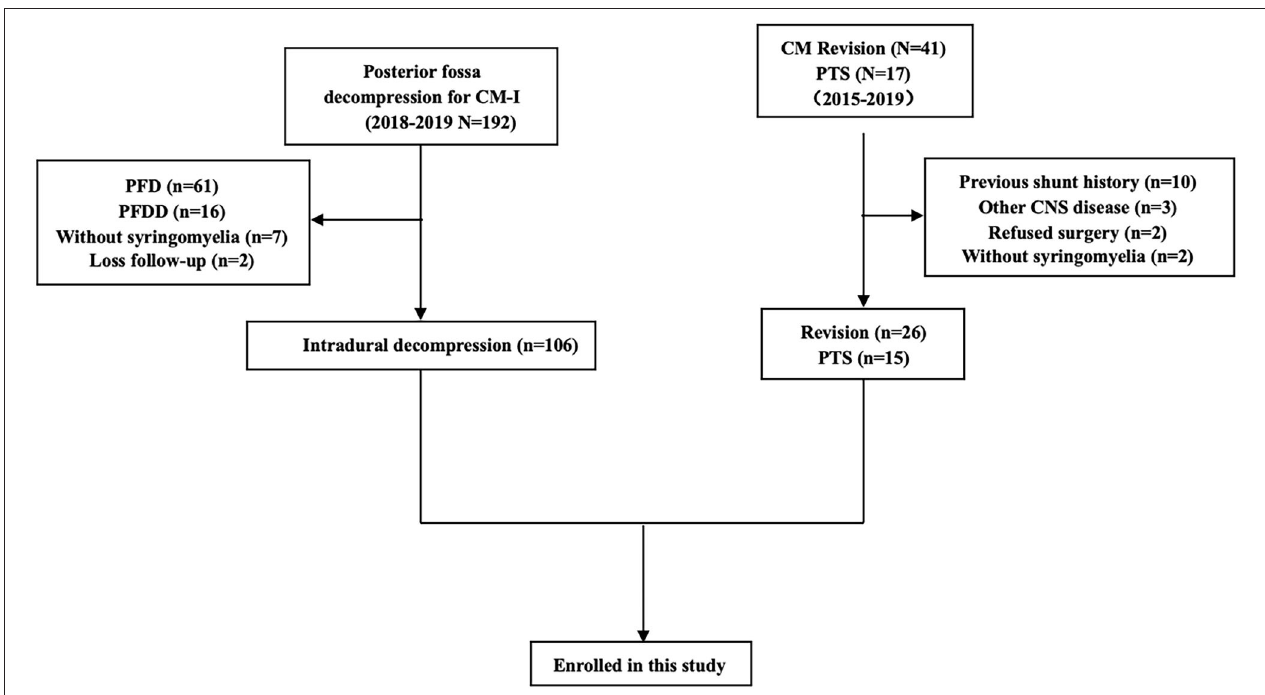
FIGURE 1 | Flow chart of 147 consecutive syringomyelia patients between 2015 and 2019.